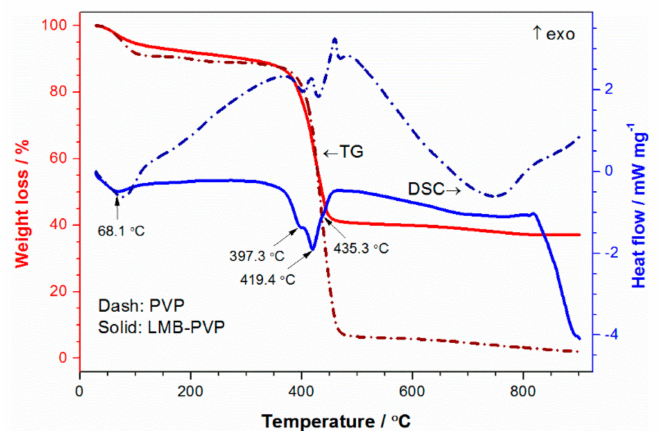
Figure 1. TG / DSC curves of LMB-PVP precursor and PVP measured in N 2 .